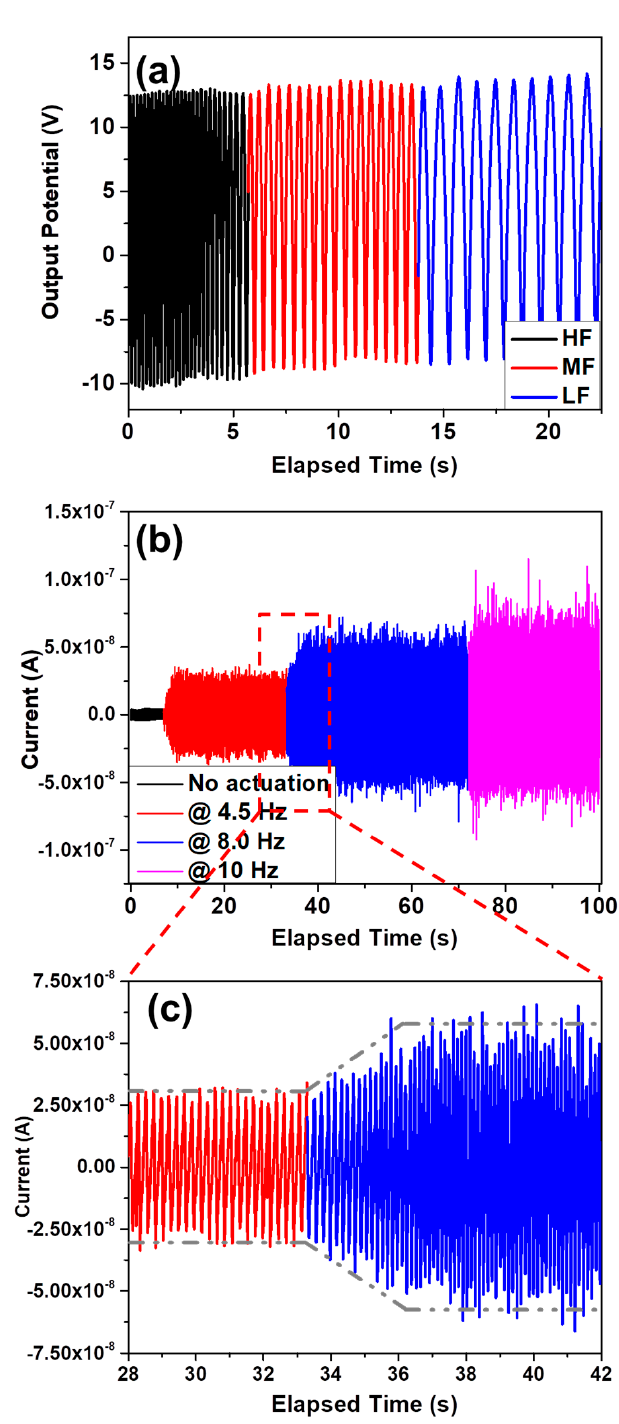
Figure 4. Piezoelectric output as a function of actuation frequency ( a ) open circuit voltages, high frequency (HF), medium frequency (MF), and low frequency (LF); ( b ) short circuit current; and, ( c ) the trend of output current by increasing the frequency of actuation source.